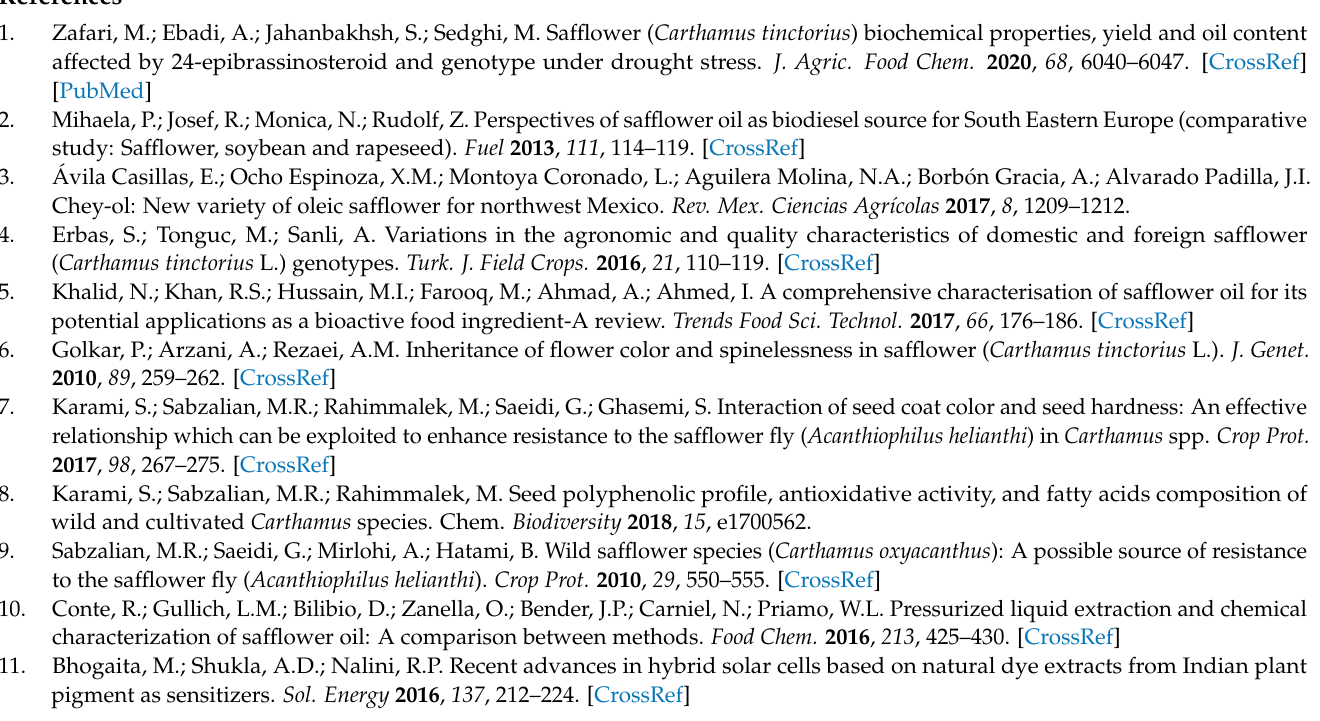
safflower of different flower and seed coat colors; Figure S2: Principal component biplots of the total oil content, fatty acid profile, phytochemical contents, and antioxidant activities of the different seed coat color groups. (A) Loading plots of genotypes with white and brown seed coat colors. (B) Loading plots of genotypes with white and dark brown seed coat colors. (C) Loading plots of genotypes with white and mix seed coat colors. (D) Loading plots of genotypes with white and light green seed coat